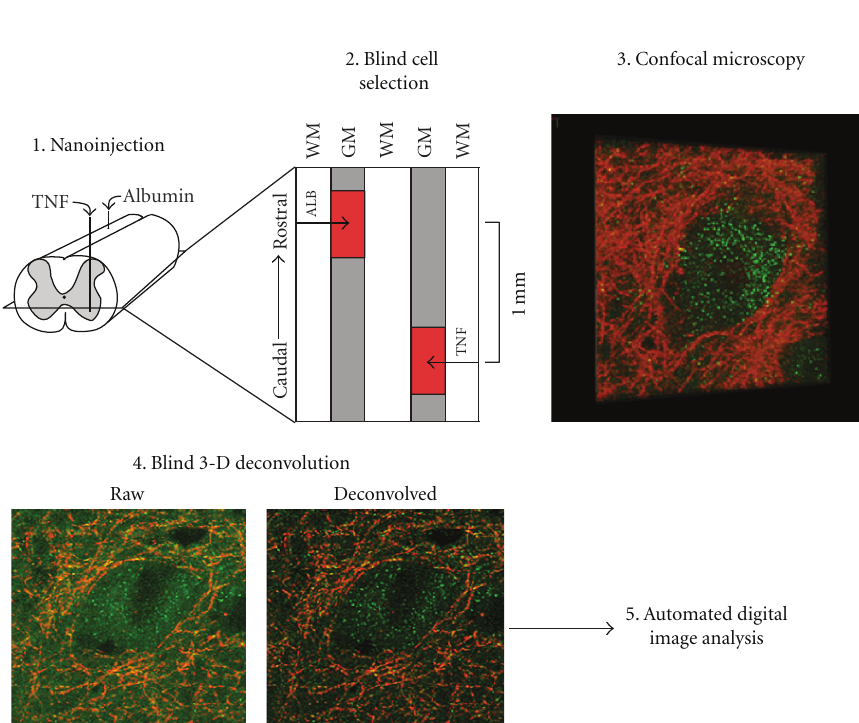
Figure 1: Overview of in vivo nanoinjection methods for confocal imaging experiments. (1) Subjects ( n = 4) received a single TNF α injection dose (0.01, 0.1, or 1 μ M) as well as a contralateral control injection of albumin. (2) Injection sites were 1mm apart along the rostrocaudal axis. Injection sites were localized using FluoroRuby (depicted as red regions). (3) Within injection sites, large ventral motor neurons were selected under wide-field fluorescence in a blinded fashion by using the characteristic pattern of presynaptic synaptophysin outlining the plasma membrane to identify cells. (4) Confocal z-stacks were deblurred by 3D blind iterative deconvolution (AutoQuant). Panels depict a z-stack before (left) and after (right) deconvolution. (5) Custom macros designed using MetaMorph software (Molecular Devices) were used to quantify the number of fluorescently-labeled receptor puncta on the plasma membrane. WM: white matter; GM: gray